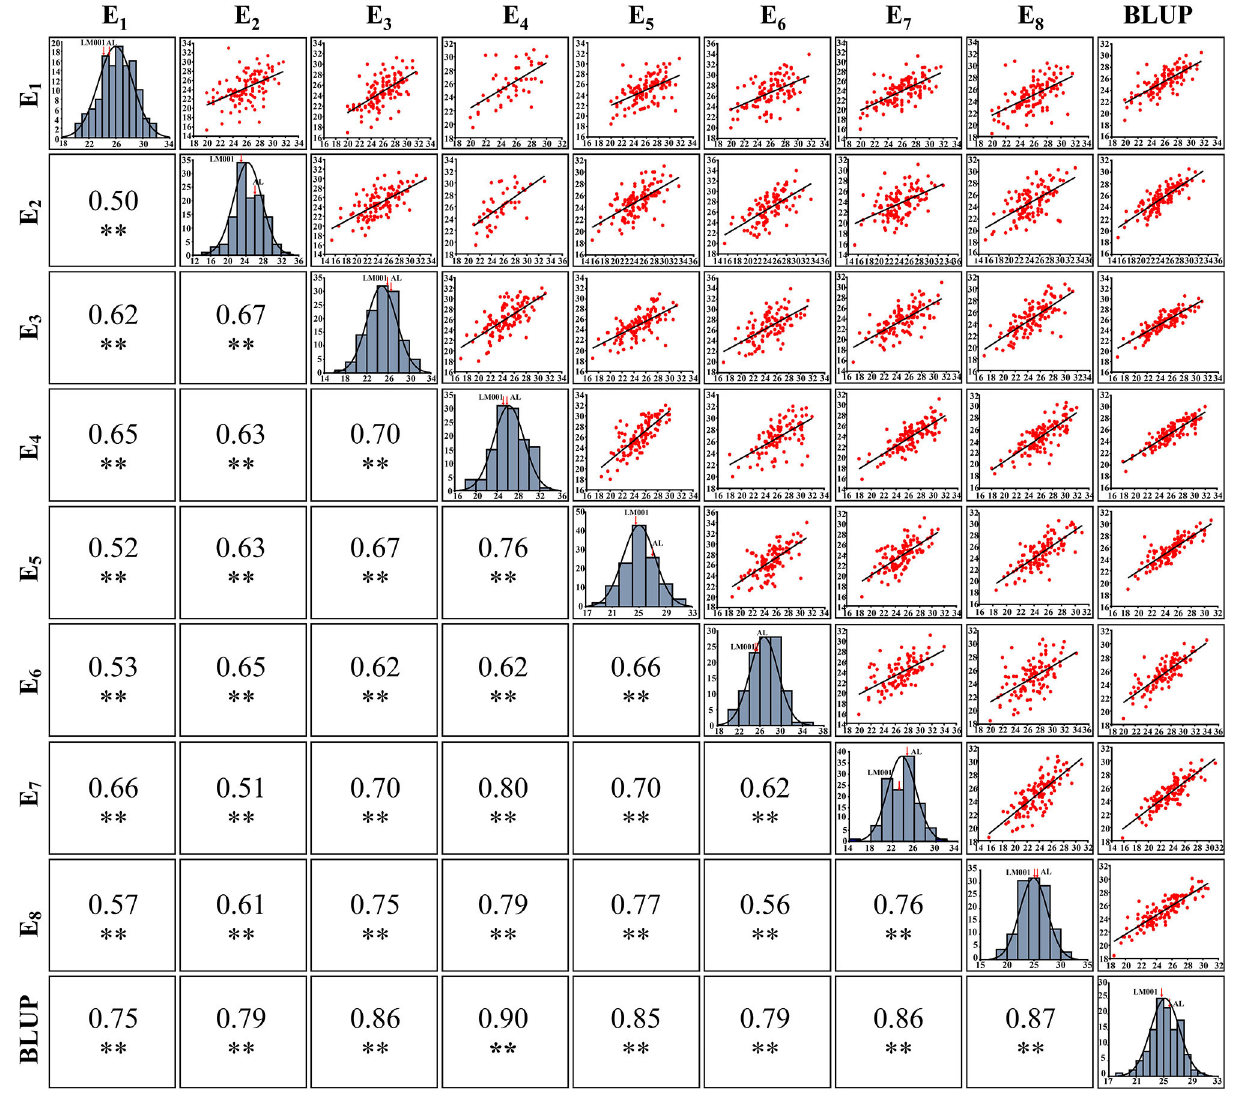
converted into KASP markers, to verify their effects in the two additional populations ( Supplementary Table 6 and Figure 6